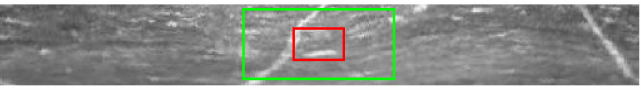
Figure 9. The selection of the template and search